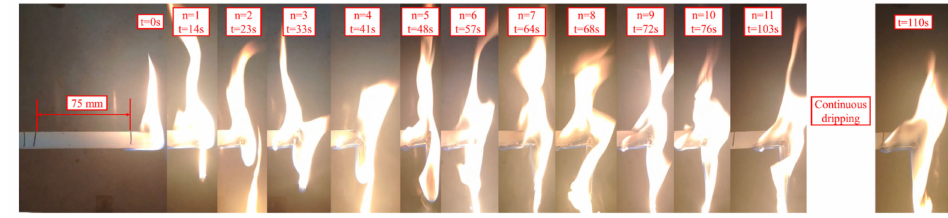
Figure 10. The combustion process of BFRPP sample during UL-94 horizontal burning test.